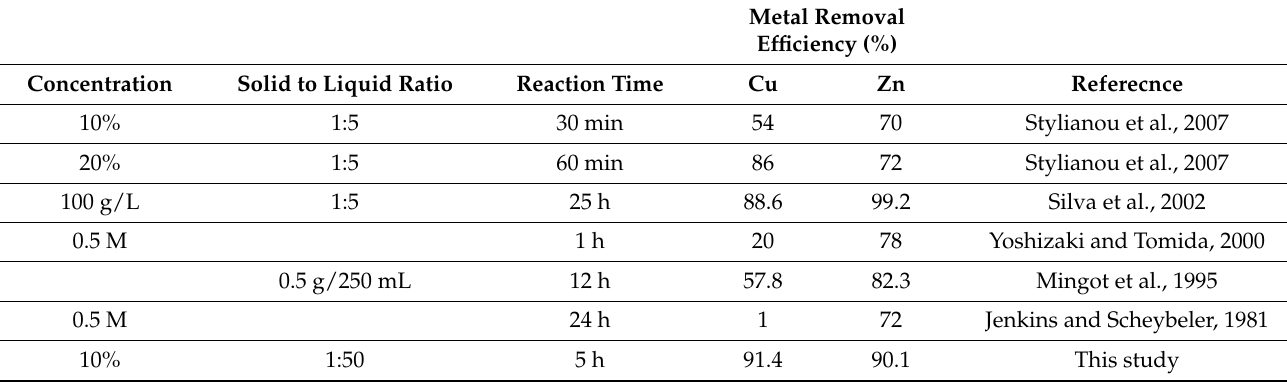
Table 3. Comparison of Cu and Zn removal from sludge by H 2 SO 4 extraction.